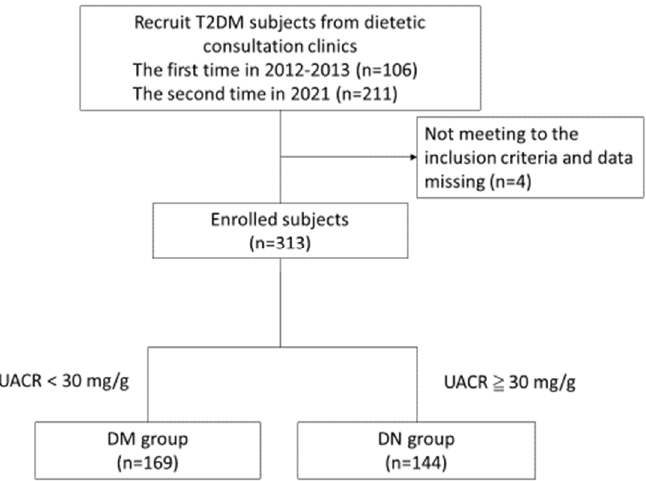
Figure 1. Participant recruitment and assignment process.